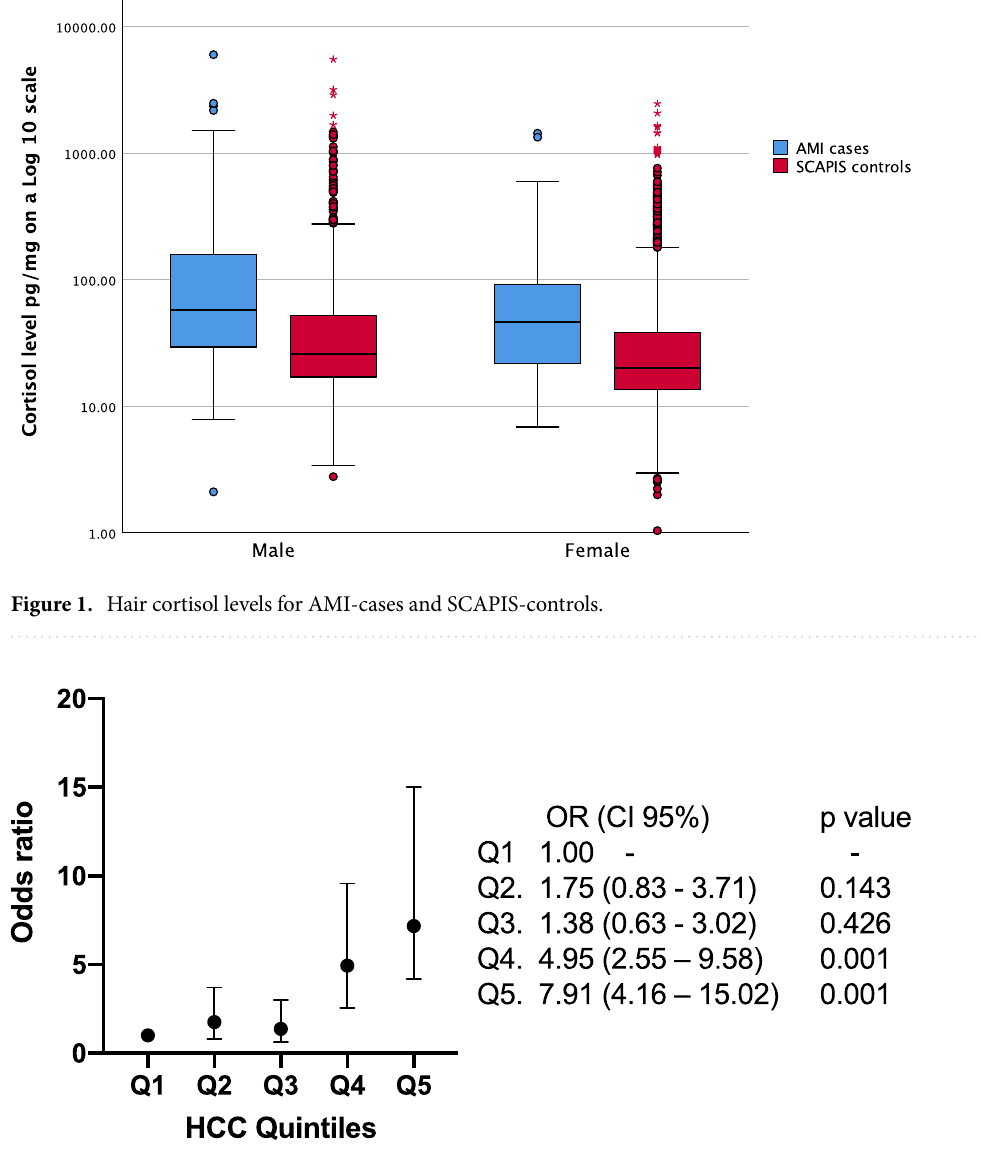
Figure 2. Odds ratios for AMI in quintiles of hair cortisol